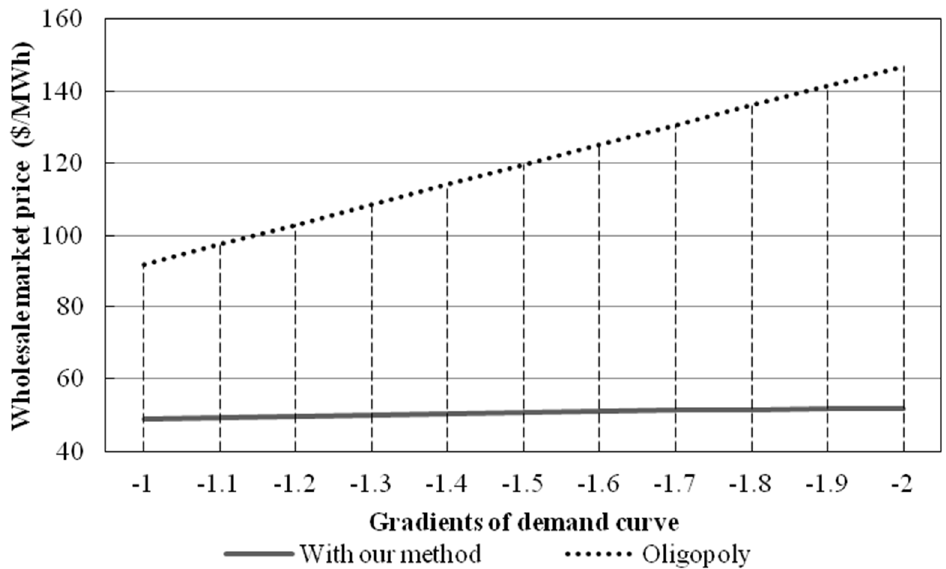
Figure 3. Market-clearing price with oligopoly conditions and with the method described here.